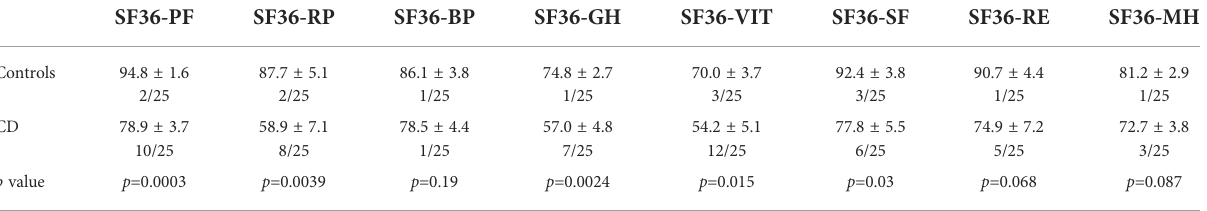
TABLE 3 Mean score in each subscale of the SF-36 for participants.